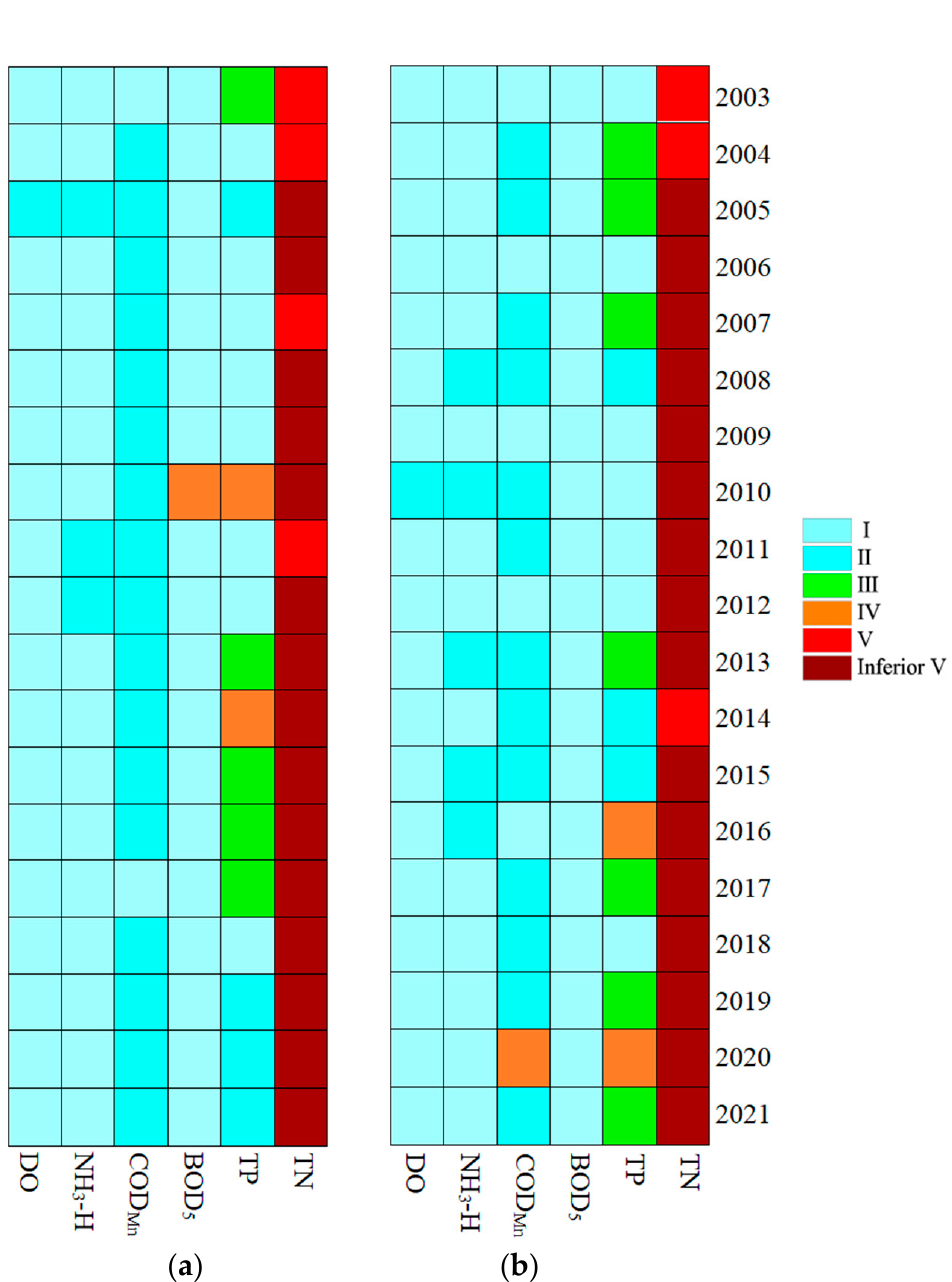
Figure 6. Water quality evaluation results for each indicator of the Gulou section from 2003 to 2021. ( a ) low water period (May), ( b ) high water period (September).